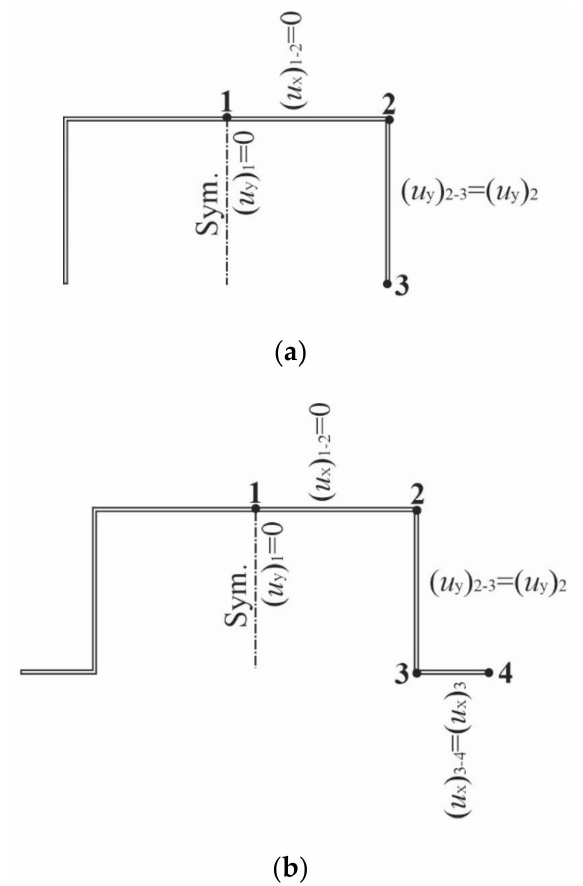
Figure 2. Boundary conditions for the C-channel ( a ) and the TH-channel ( b ) assumed in the finite element method (FEM) simulations